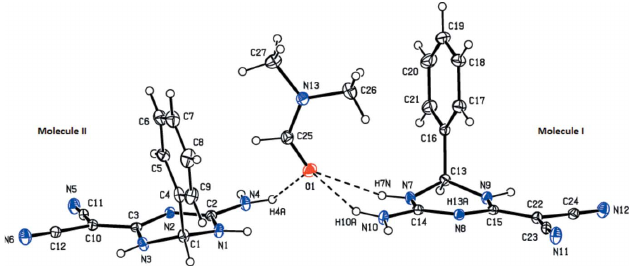
Figure 2 Least-squares overlay image ( OLEX2 ; Dolomanov et al. , 2009) of the two independent molecules ( I and II ) in the asymmetric unit of the title compound. Only the major component of disorder for molecule I is shown. Color code: carbon (gray), hydrogen (white) and nitrogen (blue).